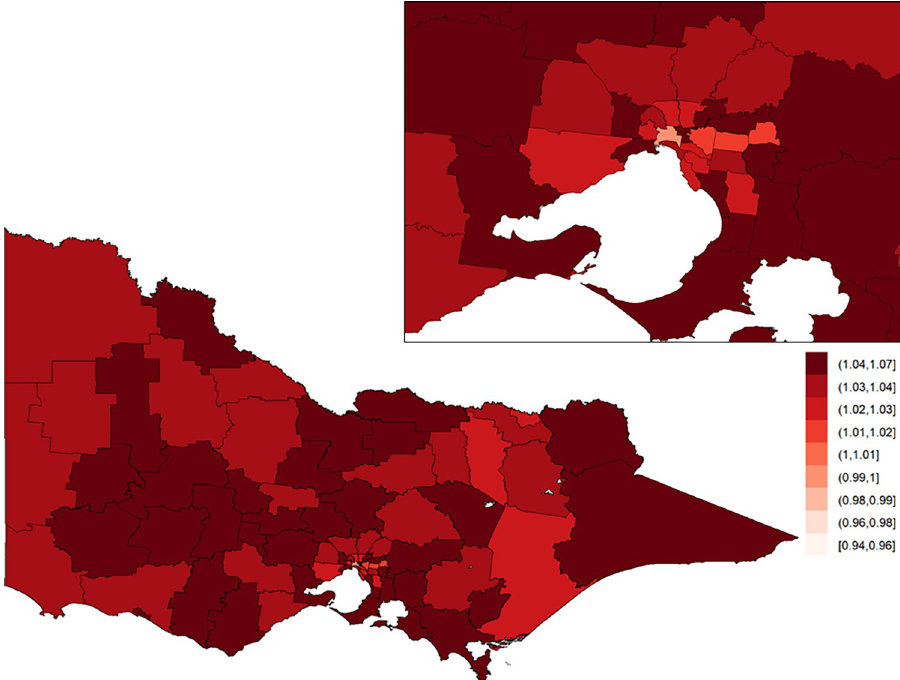
Fig 4. Area-specific yearly multiplicative change in risk for major trauma overall in Victoria. Here, a value of one indicates that the area-specific risk is stable over time; a value greater than one indicates that the area-specific risk is increasing over time; and a value less than one indicates that the area-specific risk is declining over time. The inset on the top-right shows Greater